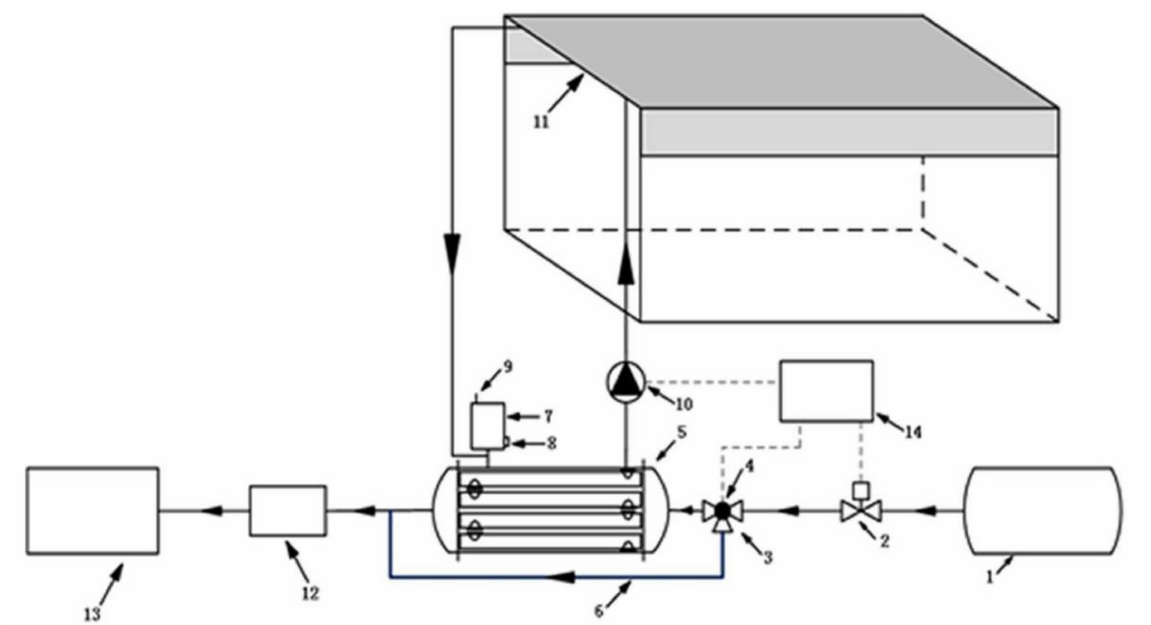
Figure 14. The schematic diagram of the radiant cooling system designed for the roof of an LNG-fuelled refrigerated vehicle: 1 , LNG cylinder; 2 , solenoid valve; 3 , three-way valve; 4 , temperature sensor; 5 , sleeve-type heat exchanger; 6 , bypass tube; 7 , coolant tank; 8 , alarm; 9 , injection port; 10 , pump; 11 , radiation structure; 12 , heater; 13 , engine; 14 , controller. Reprinted from ref.